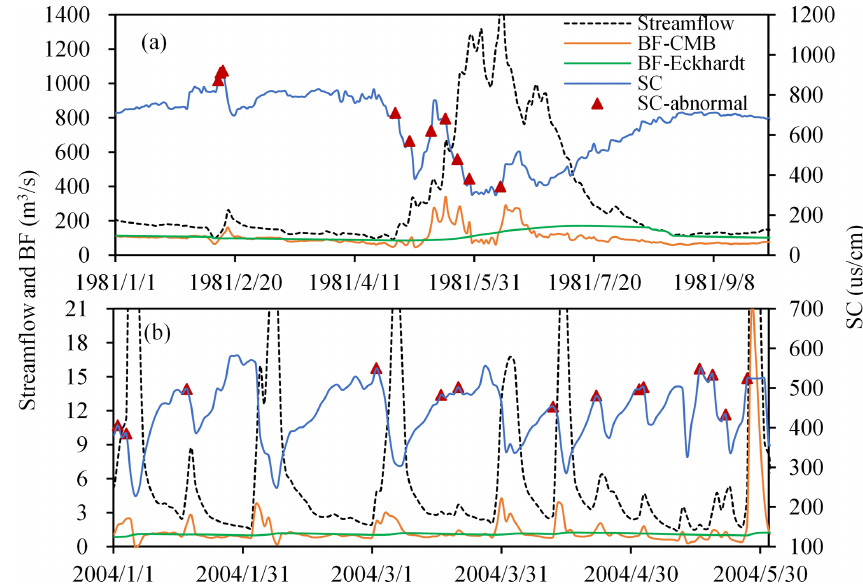
Figure 5. The abnormal increase in conductivity resulting from the flushing out of concentrated high-conductivity water from wetlands or depressions during the initial rising stage evident in the streamflow sequences of two United States Geological Survey (USGS) stations. (a) Station 06296120. (b) Station 03201980. It was assumed that this abnormal increase in conductivity was present when an increase in streamflow exceeding 10% was accompanied by an increase in conductivity. BF: baseflow; SC: conductivity.